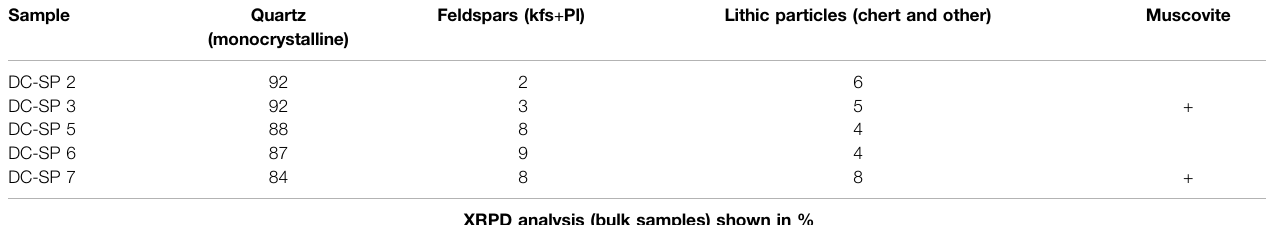
TABLE 2 | Mineral composition of silty cave sediment from pro fi le DC-SP in the Lower Cerova ˇ cka Cave. Light mineral fraction composition (fraction 0.09 – 0.16 mm) shown in %